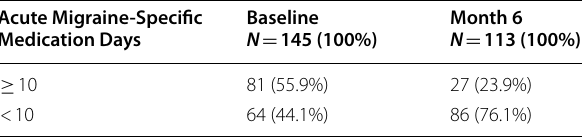
10 or < 10 acute migraine‑specific ≥